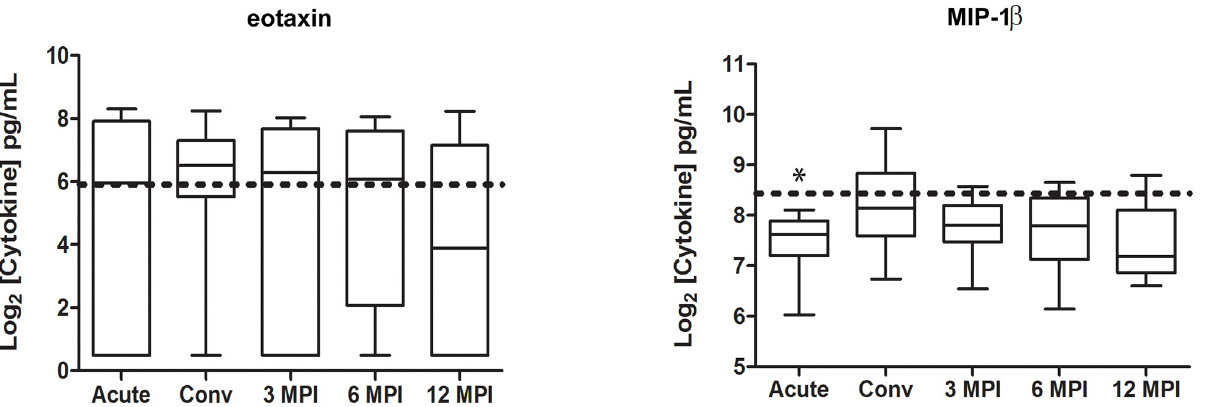
Fig 1. Kinetic profile of cytokines and chemokines similar to the concentrations detected in healthy donor controls following MAYV infection. Serum samples were collected at the acute visit as well as the convalescent visit (20 ± 10 days), at 90 ± 10 days, at 180 ± 15 days, and at 360 ± 30 days after the acute visit. The serum concentrations of a variety of cytokines were assessed by a multiplex cytokine bead array. The box plot denotes the median, 25 th percentile, and 75 th percentile cytokine levels. The whiskers denote the minimum and maximum cytokine levels observed at each time point. The horizontal dotted line represents the median cytokine values for the healthy donor controls. Comparisons between MAYV infected subjects and healthy donors were performed by a 2-tailed Mann-Whitney test ( * p <